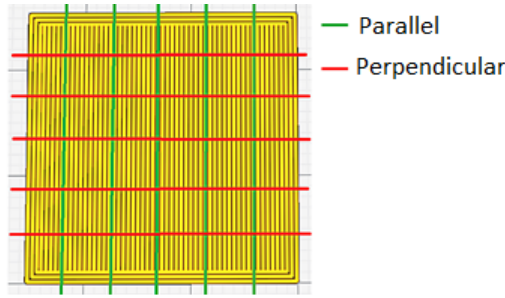
Figure 2. Directions of measurement taken in the roughness test.